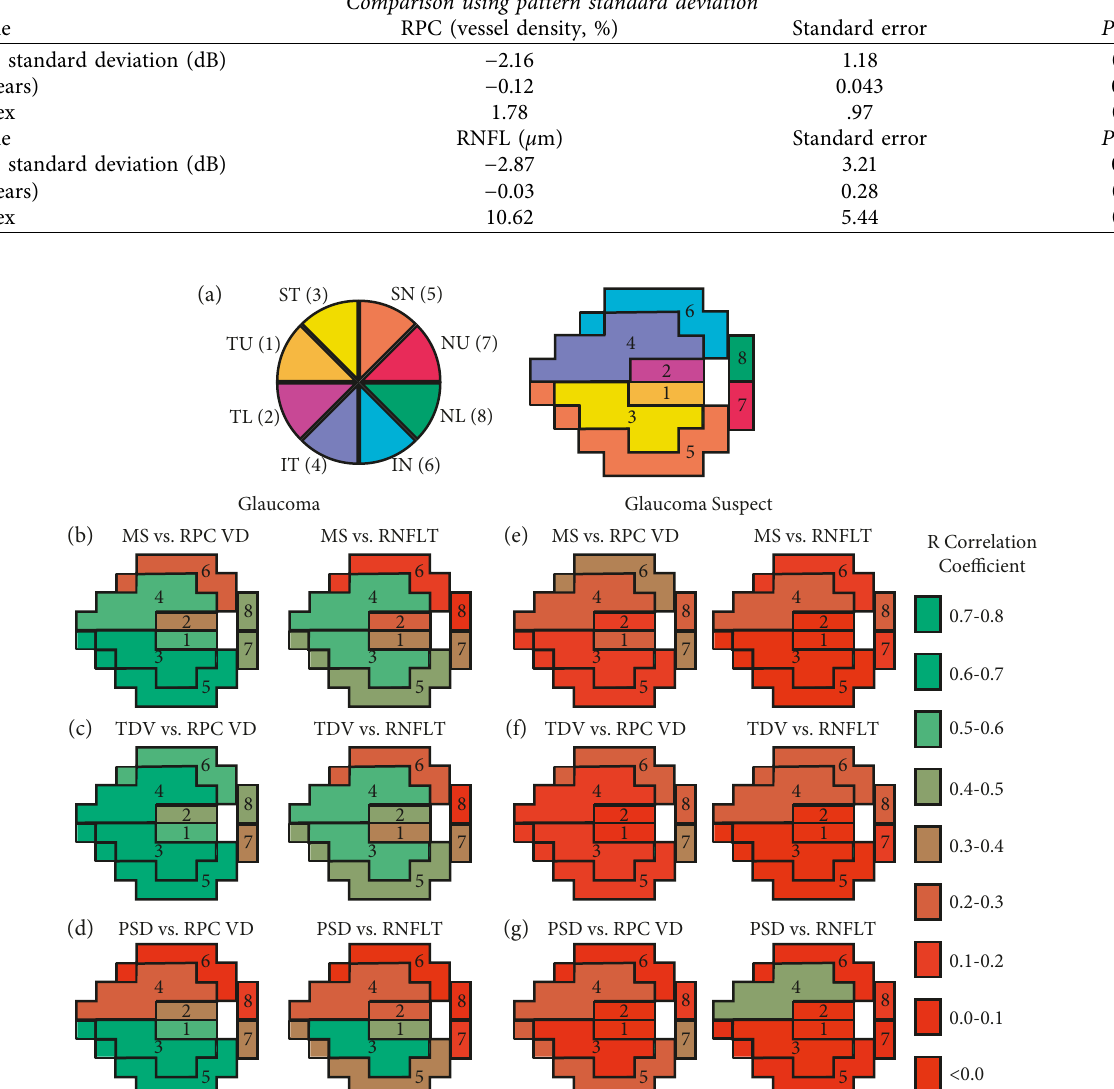
Figure 2: (a) Optic nerve head (ONH) sector divisions and the associated visual field sector numbering based on Garway–Heath mapping. These include the temporal upper (TU), temporal lower (TL), superotemporal (ST), inferotemporal (IT), superonasal (SN), inferonasal (IN), nasal upper (NU), and nasal lower (NL) sectors. Sector Pearson correlations shown for glaucoma and glaucoma suspect eyes between the mean sensitivity (MS, (b, e)), total deviation (TDV, (c, f)), and pattern standard deviation (PSD, (d, g)) with radial peripapillary capillary (RPC) vessel density (VD) or retinal nerve fiber layer thickness